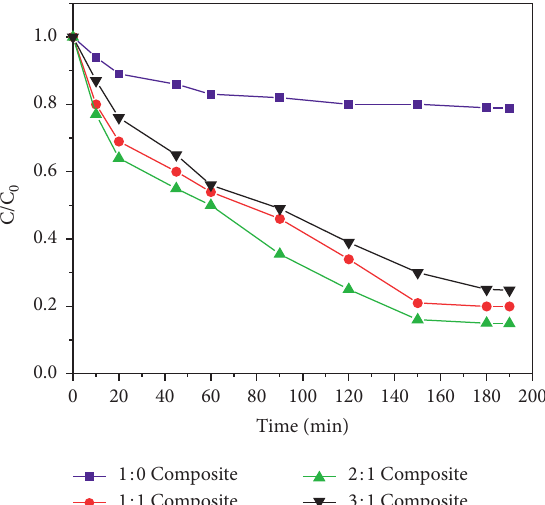
� 9.79 mM, and 2 O 2 ]